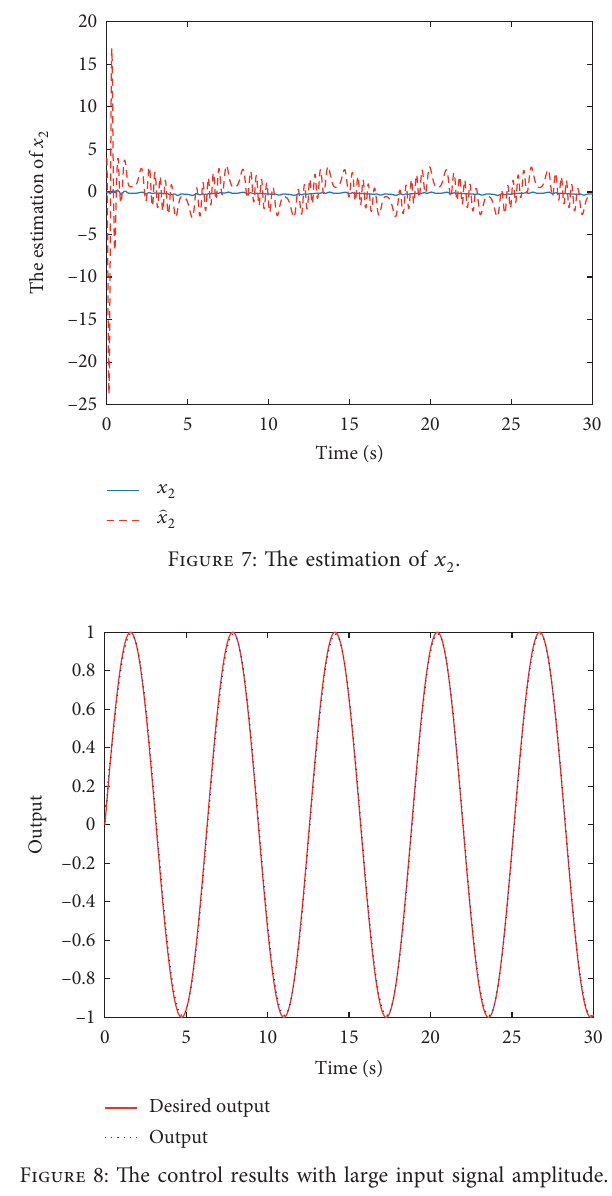
Figure 8: The control results with large input signal amplitude.